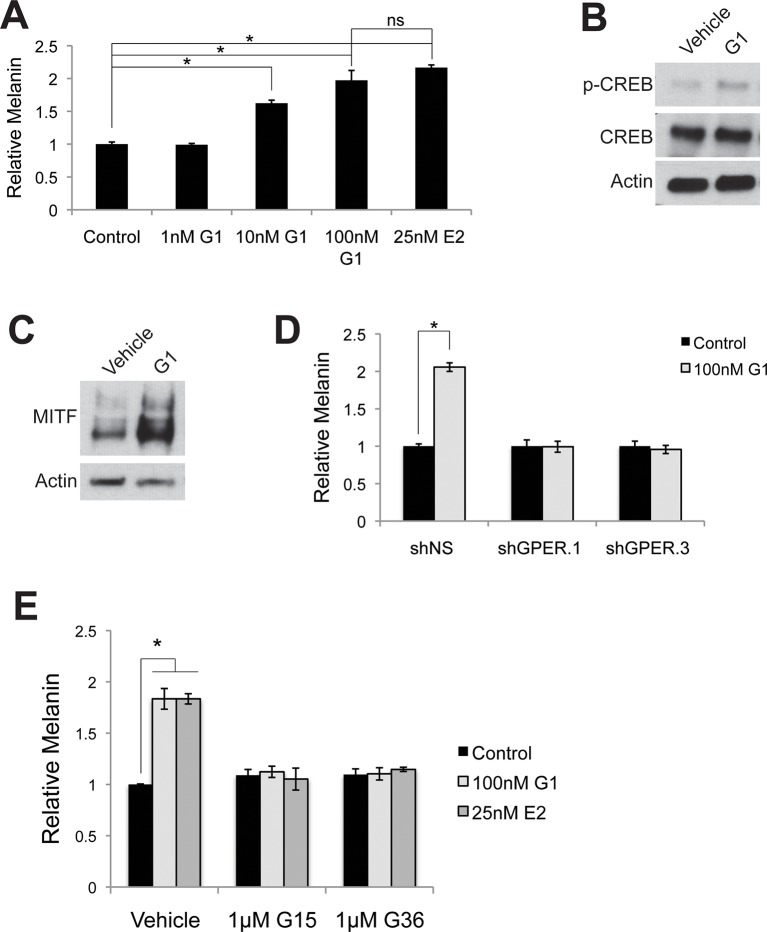
Targeting GPER with specific agonists and antagonists.(A) Melanin production in response to G-1, a specific GPER agonist. (B) Western blot demonstrating an increase in pCREB after a 30 min G-1 treatment. (C) Western blot demonstrating an increase in MITF after a 16 hr G-1 treatment. (D) Melanin assay performed on melanocytes lentivirally transduced with control shRNA or shRNA targeting GPER. These cells were treated with either vehicle or G-1. (E) Melanin production by melanocytes treated with vehicle, G-1, or estrogen, in the presence of selective GPER antagonists G-15 or G-36. n=3 biologic replicates for each experiment. Error bars denote +/- s.d., *p<0.05DOI: